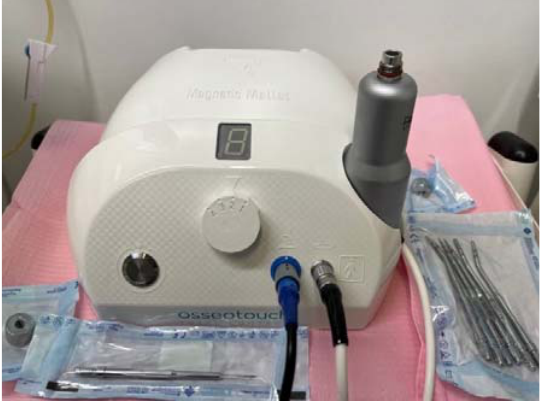
Figure 1. Magnetic Mallet with inserts for implant surgery.